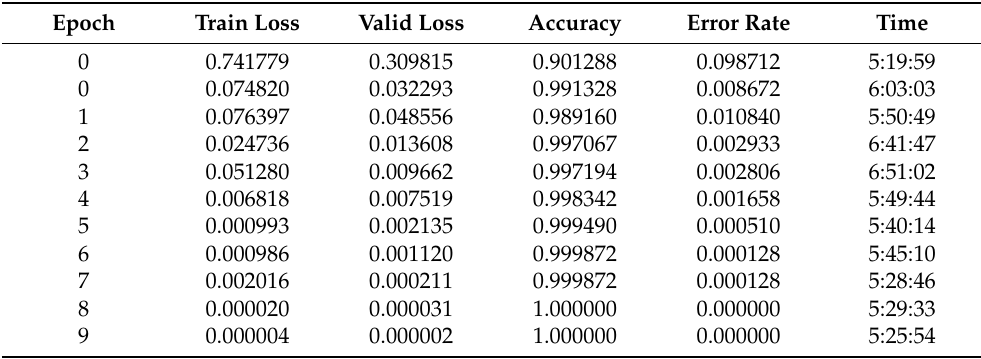
Table 8. Results of the